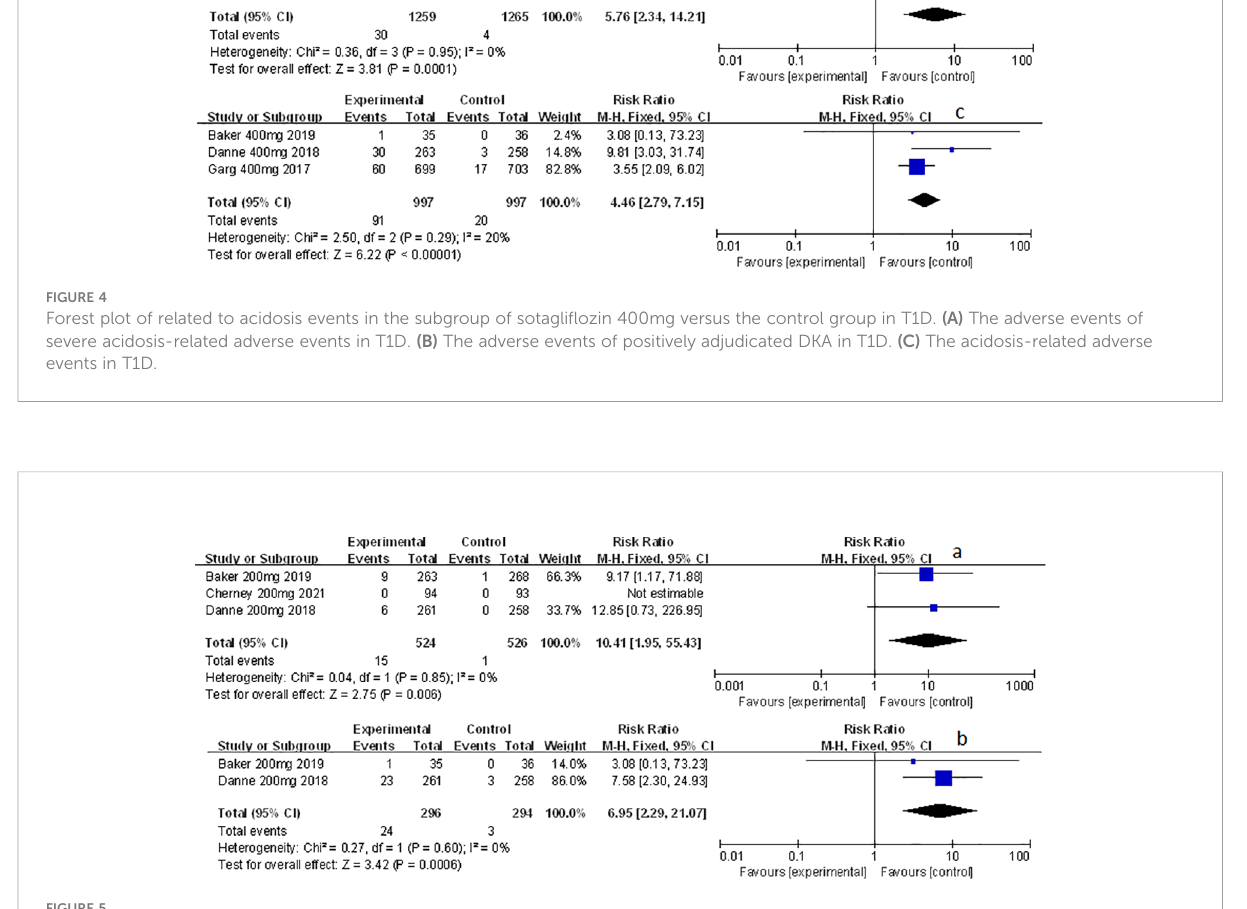
FIGURE 5 Forest plot of related to acidosis events in the subgroup of sotagli fl ozin 200mg versus the control group in T1D. (A) The adverse events of DKA in T1D. (B) The adverse events of acidosis-related event in